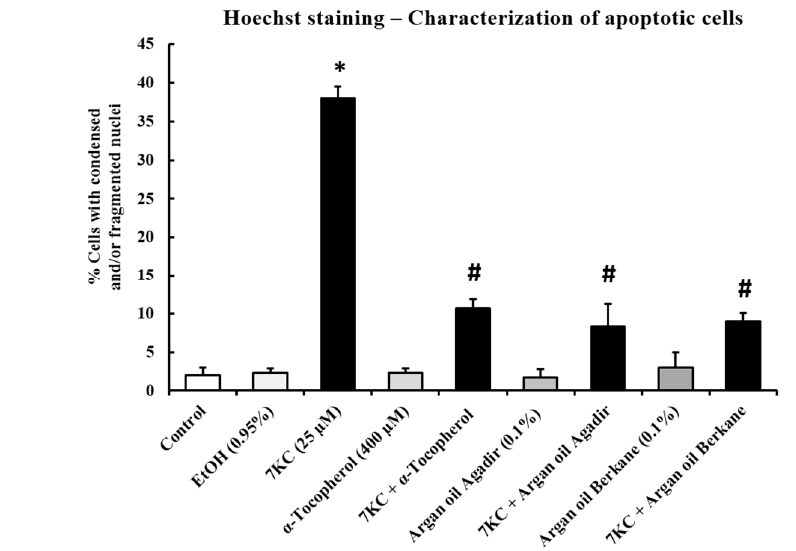
Figure 7. Effects of argan oil on 7-ketocholesterol-induced apoptosis evaluated by condensation and/or fragmentation of the nuclei. After 24 h of culture, 158N murine oligodendrocytes were cultured for an additional 24 h without or with 7KC (25–50 µM) in the absence or presence of argan oils (Agadir or Berkane; Morocco; 0.1% v / v ) or of α -tocopherol (400 µM) used as the positive control. Argan oils and α -tocopherol were added to the culture medium 2 h before 7KC. Apoptosis was evaluated by the percentage of apoptotic cells characterized by condensed and/or fragmented nuclei whereas control cells (untreated cells) have round and regular nuclei. Data are mean ± SD of two independent experiments carried out in triplicate. The significance of the relationship between vehicle and cells treated with 7KC, argan oils or α -tocopherol was calculated by the Anova test (Sidak’s multiple comparisons); * p ≤ 0.05. The significance of the relationship between cells treated with 7KC alone, 7KC and argan oils cotreatment, or 7KC and α -tocopherol cotreatment was calculated by the Anova test (Sidak’s multiple comparisons); # p ≤ 0.05. No difference was observed between control and vehicle (EtOH 0.95%)-treated